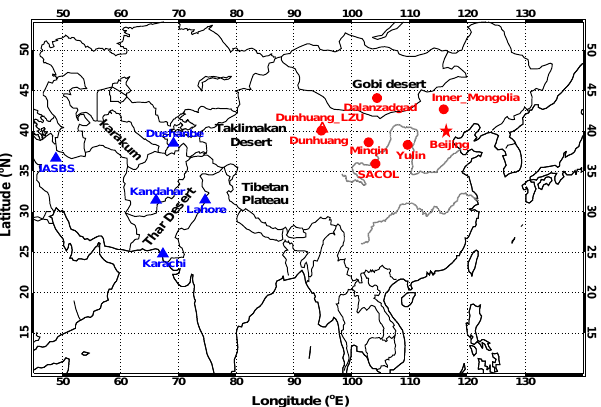
Figure 1. Geographical location of selected 13 AERONET sites in this study. Eight sites over the East Asian region are labeled with red colors, and five sites over the Central Asian region are labeled with blue colors. The major deserts along with plateaus are marked in black